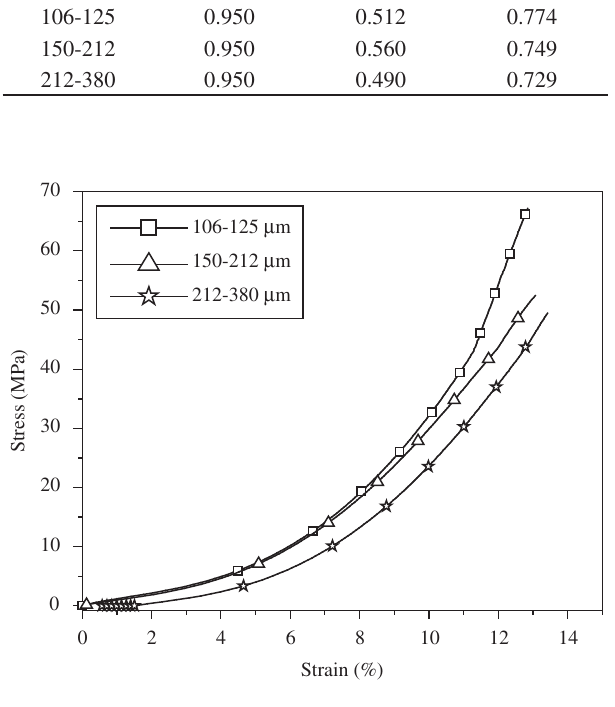
Figure 2. Stress versus strain curves for the HDPE specimens prepared with different particles size.